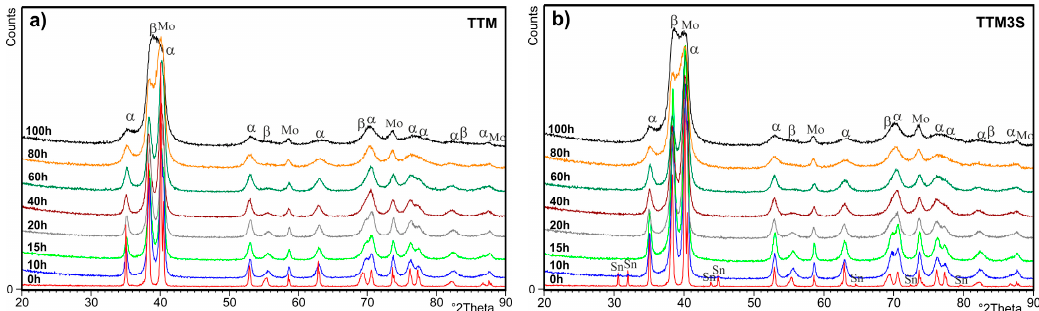
Figure 6. X ‐ ray diffraction patterns and changes in the weight fractions of the α , β and Mo phases of ( a ) TTM and ( b ) TTM3S powders after 10, 15, 20, 40, 60, 80 and 100 h of milling.